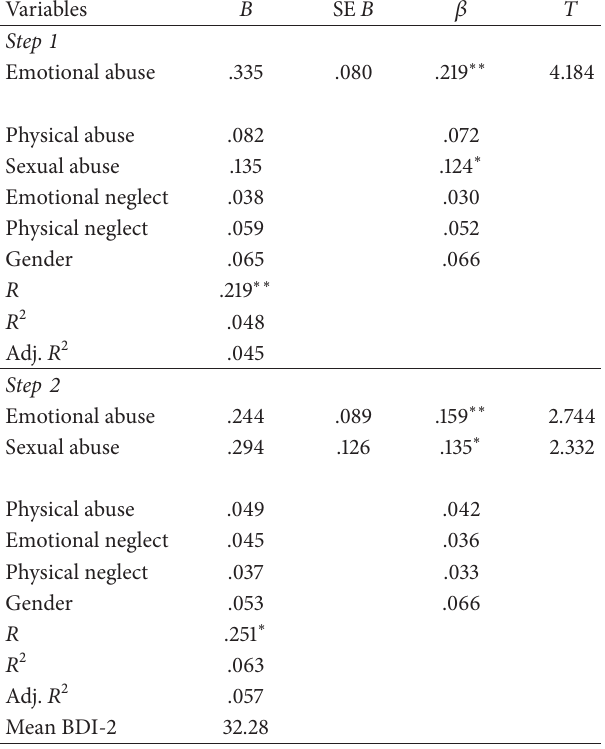
Table 7: Results of stepwise regression analysis for depression symptom severity (BDI-2), trauma subtypes, and gender ( 𝑛 = 349 ) (Model 1).